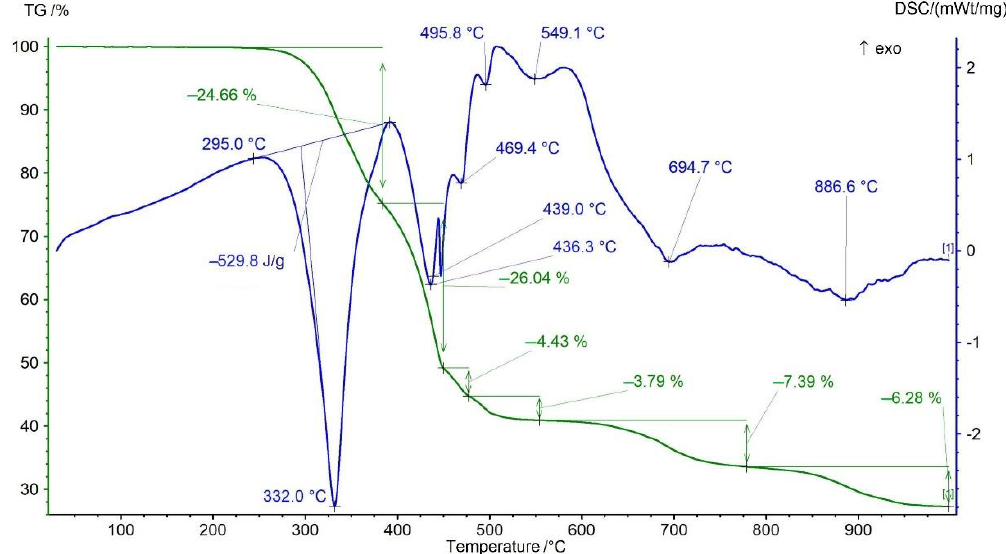
Figure 7. TG-DSC curves of a concentrate mixture with ammonium sulfate at a ratio of 1:2.